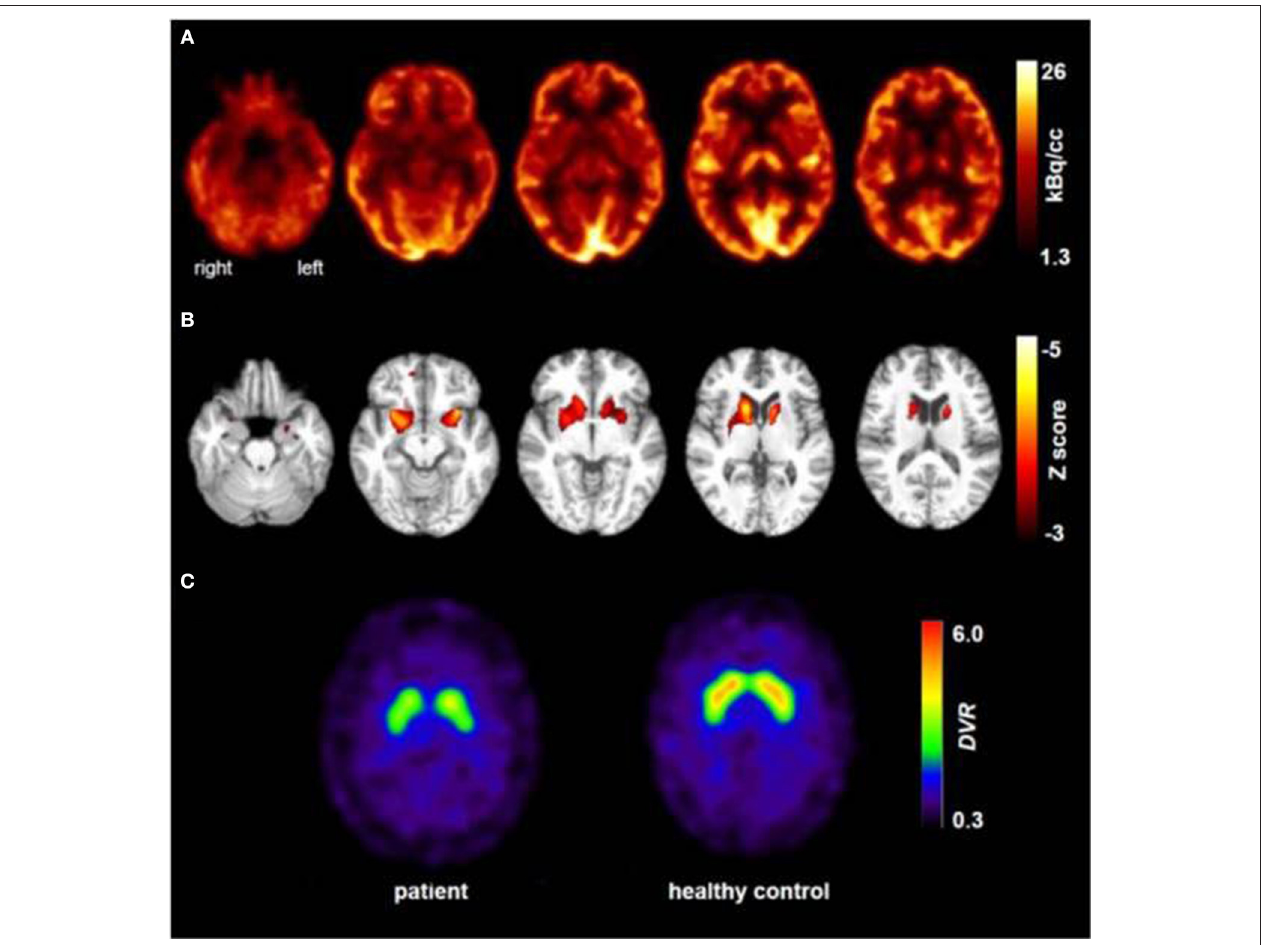
FIGURE 1 | Results of molecular imaging studies. Transaxial [ 18 F]FDG-PET images (A) showed not only a mild bilateral mesiotemporal hypometabolism (in line with mesiotemporal seizure origin) but also a marked striatal hypometabolism that was found to be highly significant compared to healthy controls [ (B) ; results of a statistical parametric mapping analysis comparing the patient’s scan to those of 10 age-matched healthy controls; clusters of voxels with significant hypometabolism (voxel threshold: p < 0.001, cluster extent threshold k > 20 voxels) are color-coded as Z score and overlaid onto the spatially-normalized MRI scan of the patient]. An additional [ 123 I]FP-CIT-SPECT examination (C) also revealed a moderate loss of striatal dopamine transporters, witnessing a decline of nigrostriatal integrity (an age-matched healthy control is shown for comparison; DVR , distribution volume